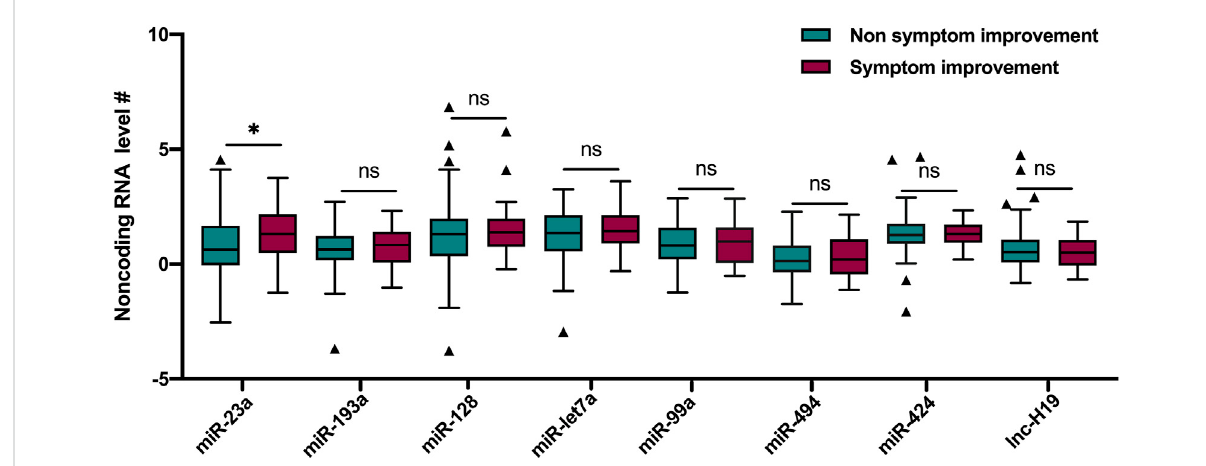
FIGURE 1 Comparisons of noncoding RNAs between patients with and without symptom improvement at 24 h after rtPA treatment. # Ln transformation of the eight noncoding RNAs. Lines of the boxes represented medians, and error bars represented interquartiles. rtPA, recombinant tissue plasminogen activator. miR, miRNA; lnc, lncRNA.